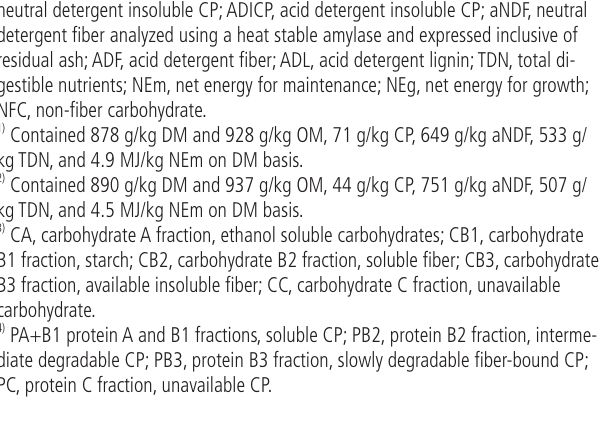
Table 2. Analyzed chemical composition (g/kg DM or as stated) of experimental total mixed ration Items